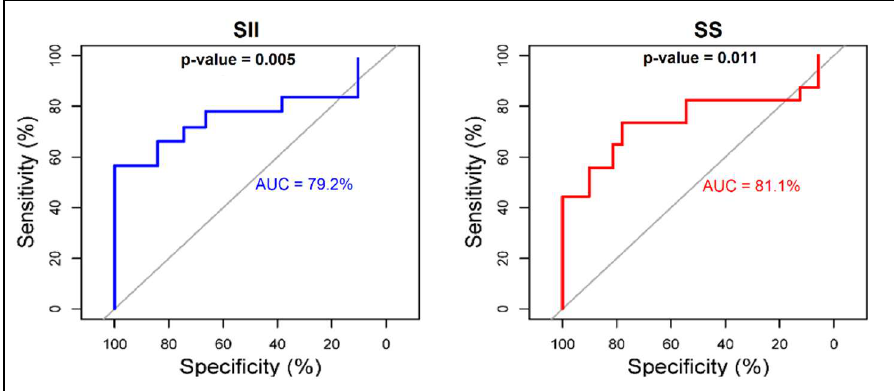
Figure 3. ROC plot for the accuracy of SS and SII in predicting SIRS using admission features in patients with odontogenic